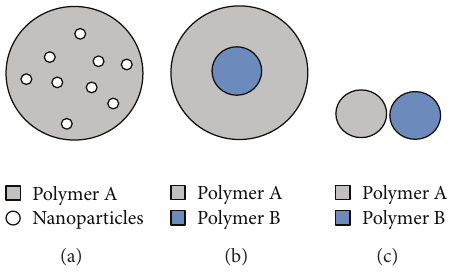
Figure 3: Schematic cross-sectional view of different structures of composite nanofibers: (a) randomly blended; (b) core-shell; (c) mingled structure generated from various capillary needle